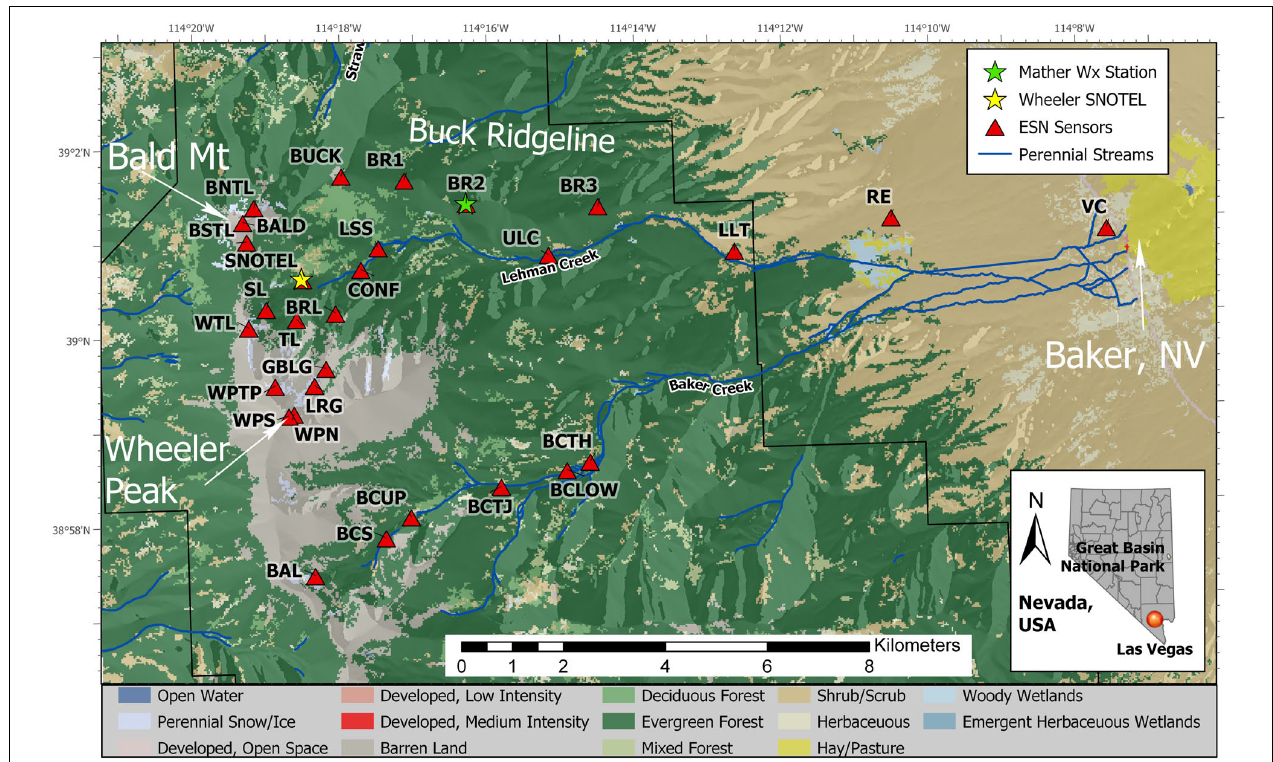
FIGURE 1 | Hillshade map of GBNP illustrating sensor locations along Lehman and Baker creeks below Wheeler Peak. Colors depict landcover type, identified in key. Nearby weather stations, location of Baker, NV (nearest town) and general stream hydrography are also illustrated. Sensors are identified by codes relating to Table 1 and Figure 2 . Location of GBNP and Las Vegas (red circle) are shown in inset map of